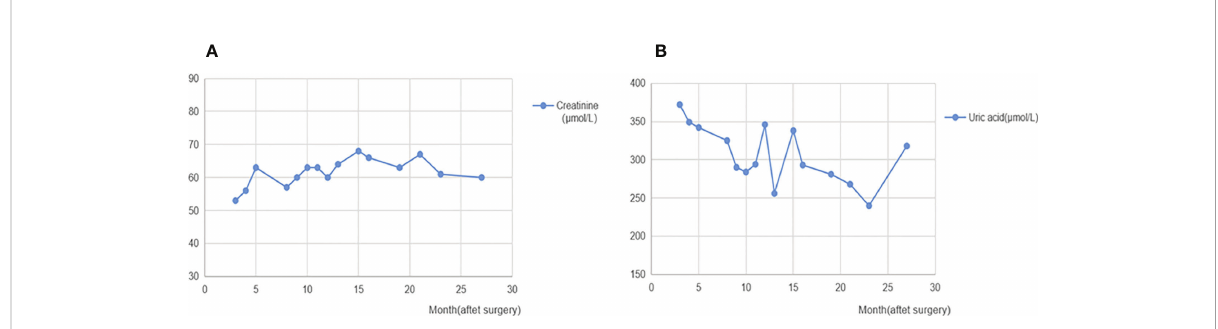
FIGURE 3 Creatinine and uric acid after surgery. (A) : Changes of creatinine after surgery. (B) : Changes of uric acid after surgery. The levels of creatinine and uric acid after surgery follow-up were in the normal